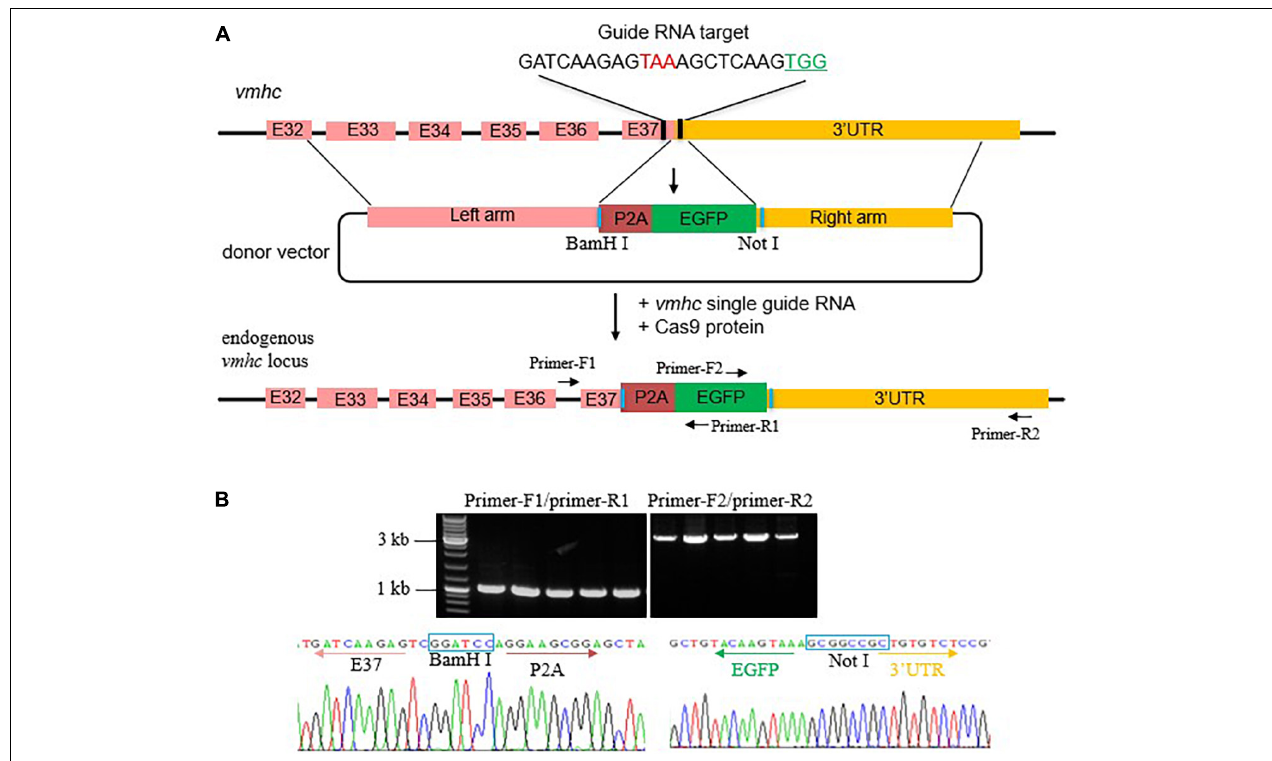
FIGURE 1 | Generation of the vmhc KI − EGFP zebrafish KI line. (A) Schematic diagram of the KI strategy based on the HR pathway triggered by the CRISPR/Cas9 system. The TAA stop codon (in red) is included in the guide RNA target sequences. Protospacer adjacent motif (PAM) sequences are marked in green. The donor vector used for HR contains the left homologous arm, P2A-EGFP, and right homologous arm. Restriction enzymes sites used for left and right homologous arms cloning are marked in blue. (B) Correct integration of P2A-EGFP into the C-terminal of the endogenous vmhc locus was confirmed by genotyping PCR and Sanger sequencing in the F1 stable KI embryos.